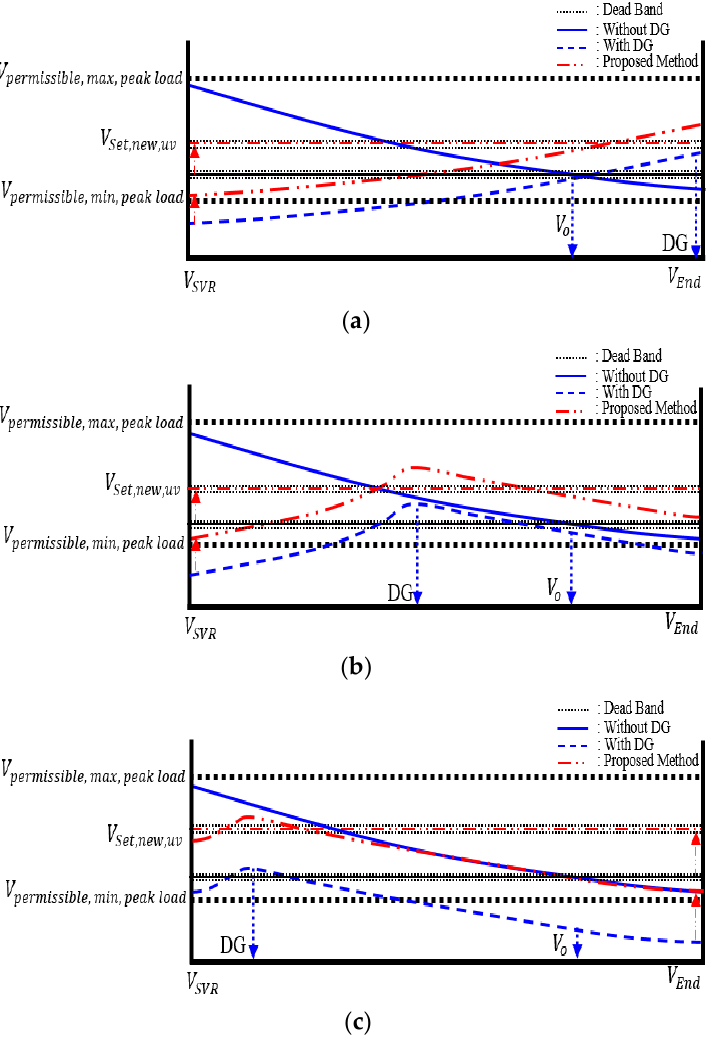
Figure 8. Voltage Profile by proposed SVR tap-control algorithm at peak load: ( a ) Case I; ( b ) Case II; ( c ) Case III.